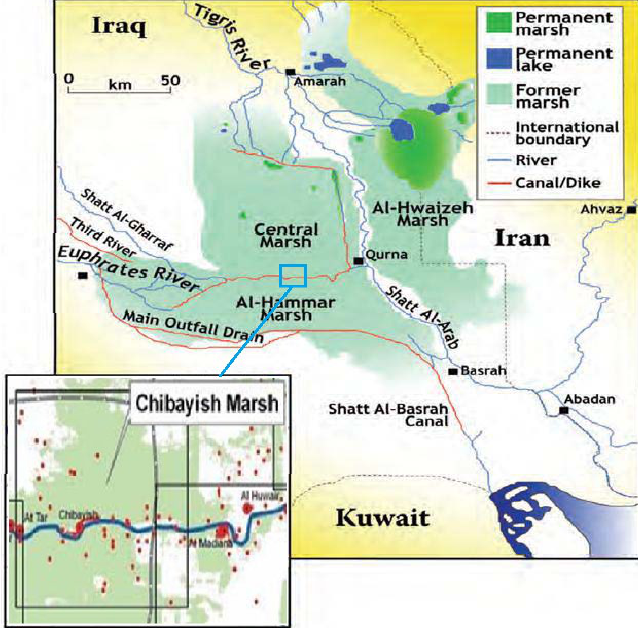
Figure 1. Al-Chibayish marsh geographic location in Iraq (Source: UNEP 2010 modified by